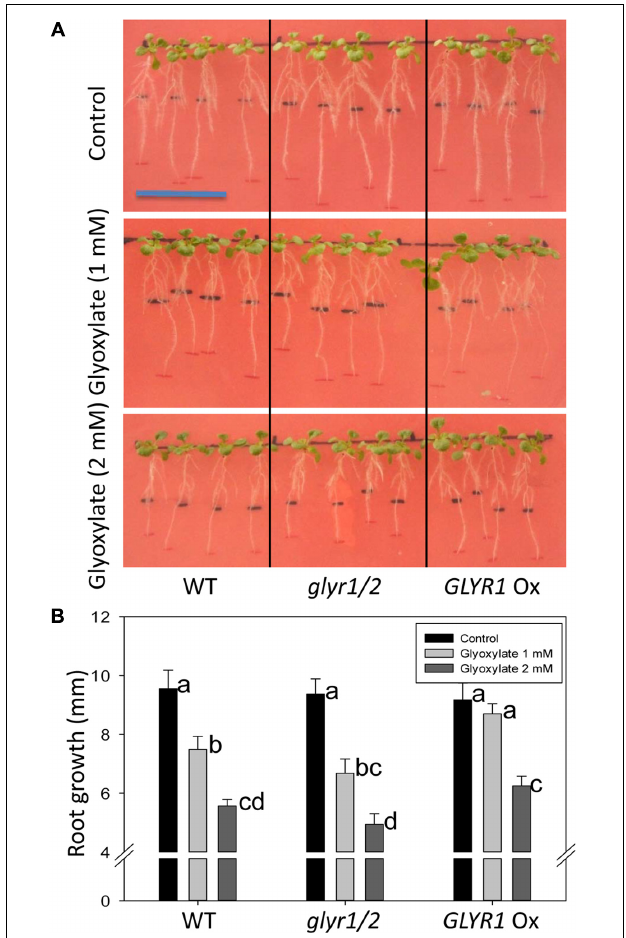
FIGURE 4 | Impact of Arabidopsis genotype on the response of root growth to glyoxylate under chilling stress. Seeds of WT, glyr1/2 and GLYR1 Ox were sown on plates containing half-strength MS medium and grown at ambient temperature for 8 days. Then the plantlets were transferred to new agar plates containing 0 (control), 1 or 2 mM glyoxylate, as indicated on the y-axis, grown at 10 ◦ C for another 8 days, and then the gain in root length was determined (A) . Results are the least squared means ± SE of measurements from 10 plates (three plants per plate) estimated following two-way analysis of variance (ANOVA) performed in PROC MIXED procedure in SAS with P = 0.05 as the significance threshold. (B) Error bars sharing the same letter are not significantly